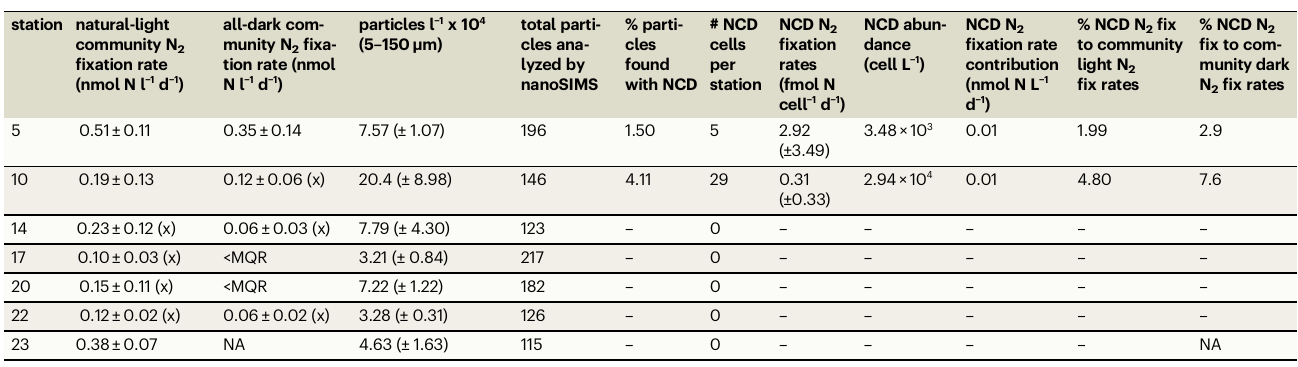
Calculations representvaluesscaled-upfrom a limited analysisandshould beconsideredas roughestimatesincluded forcontext. Thebasis oftheestimateswere madeusing the particle concentrationandthepercentofanalyzedparticleswithanassociatedputativeNCDtocalculate ‘ NCDabundance ’ , ‘ NCDN 2 fi xationratecontribution ’ ,and ‘ %NCDN 2 fi xtocommunitylight/darkN 2 fi x rates ’ . Valuesrepresentmean (±standarddeviationofthemean)at each station, N 2 fi xation rates marked with an ‘ x ’ are above the MQR but below the